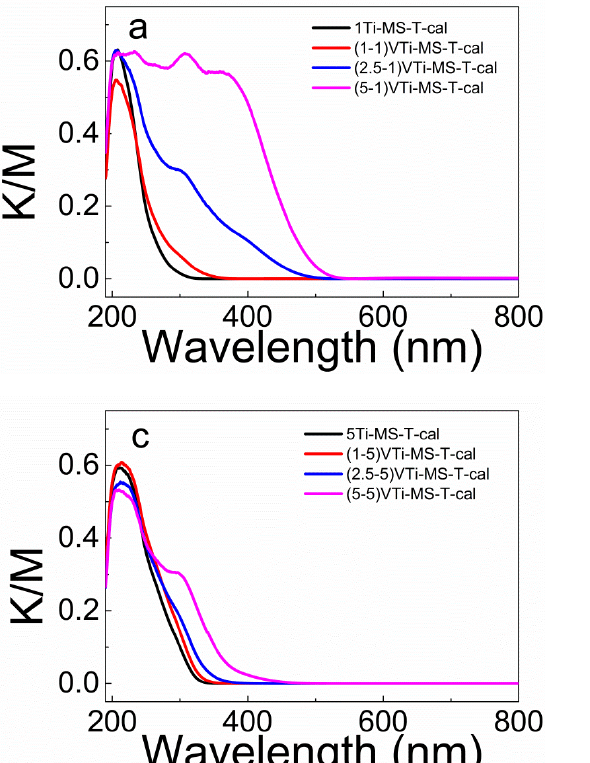
Figure 1. UV–vis spectra of 1V-MS-L-cal and (1–2.5)VY-MS-T/L-cal (Y = Ti/Al/Zr/Ce). MS-L-cal was used as blank, and before measurement, samples were diluted in MS-L-cal to keep the spectral intensity in the range of 0.2–0.8 K/M (K/M = Kubelka–Munk function).